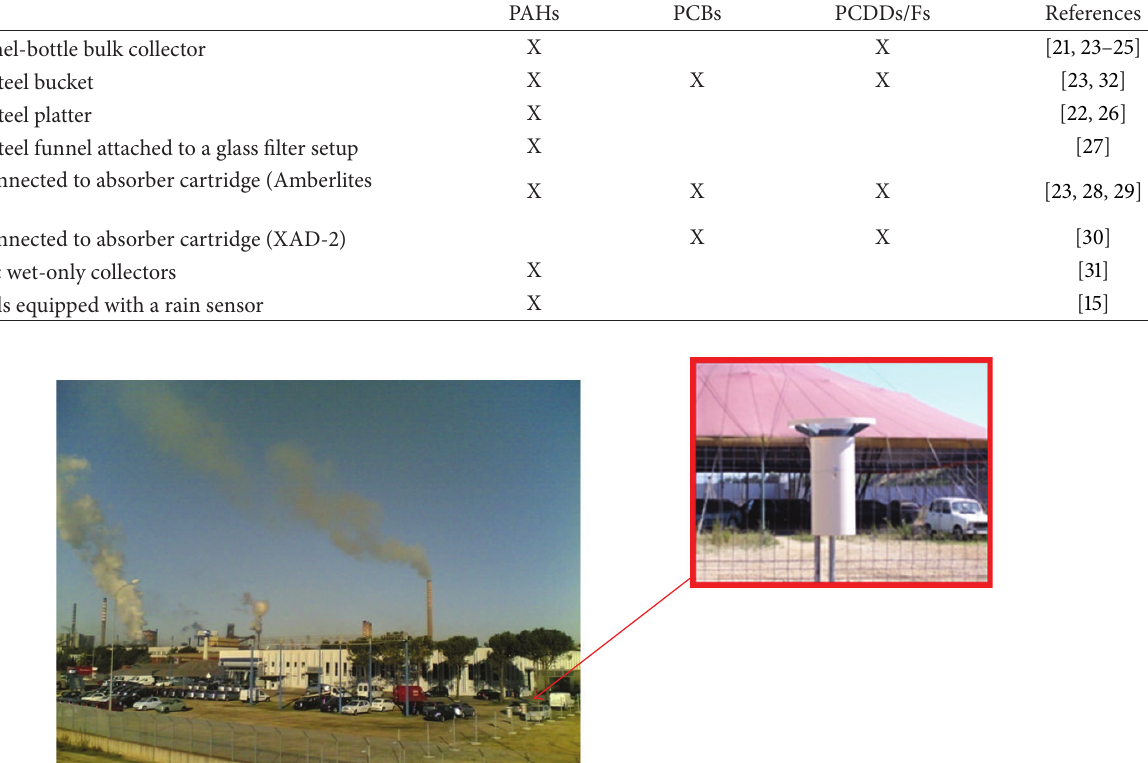
Figure 1: Bulk deposition sampler positioned round the borders of an industrial site in Taranto